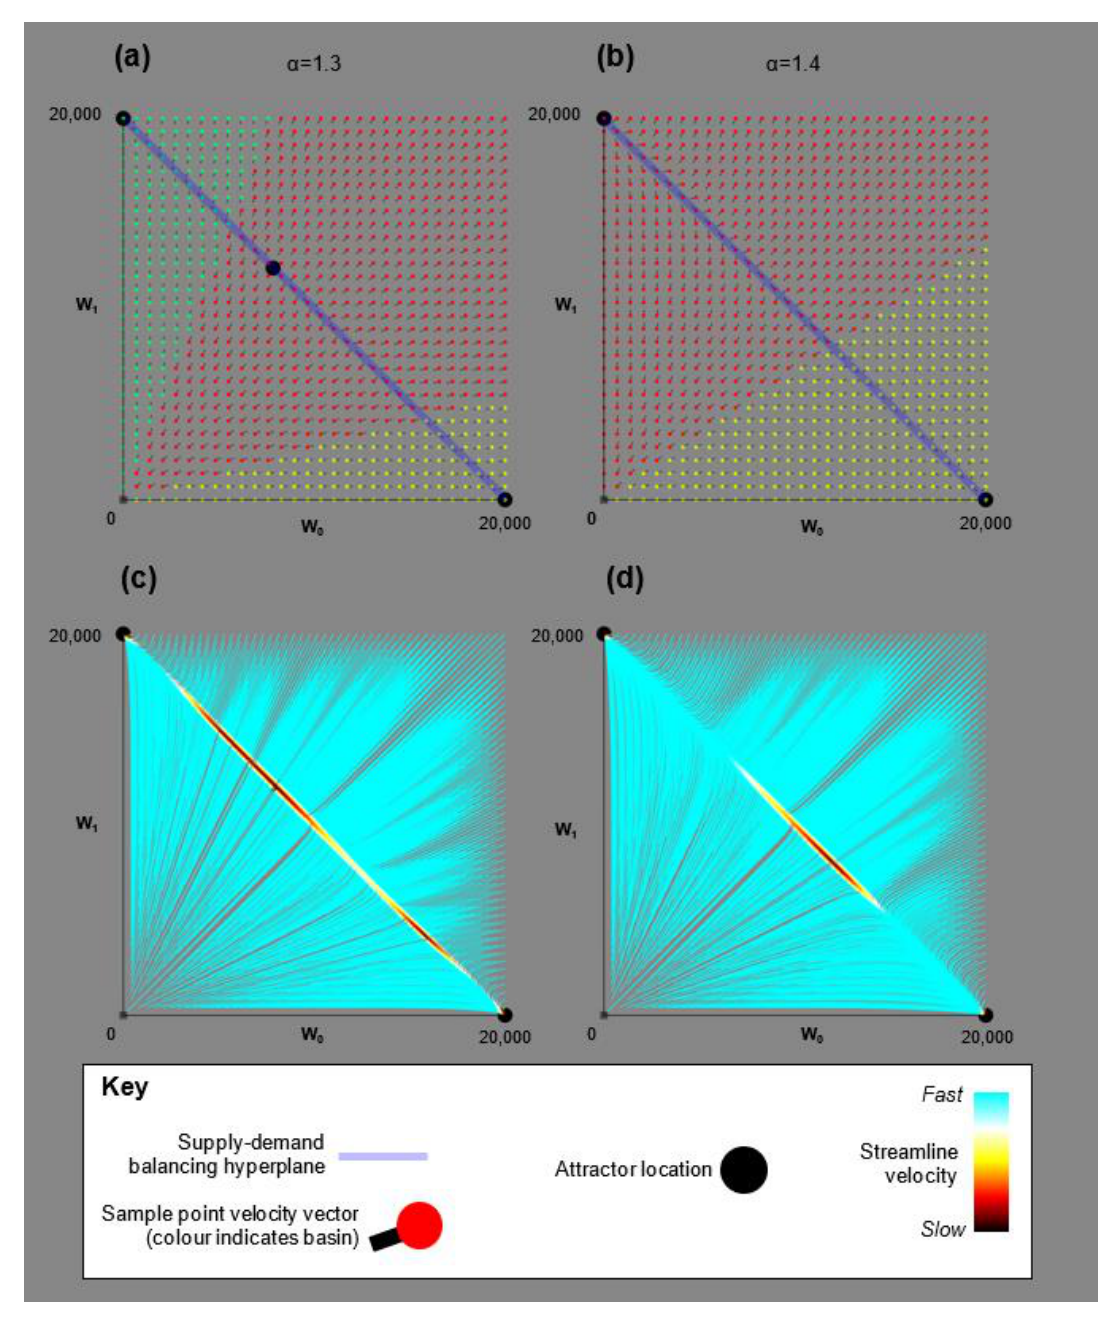
Figure 2. The state space of region R1 across two parameter sets: ( a , b ) 30 × 30 vector field plot showing three basins, ( c , d ) 50 × 50 streamlines with velocity colour-coded. Note: b = 0.4.